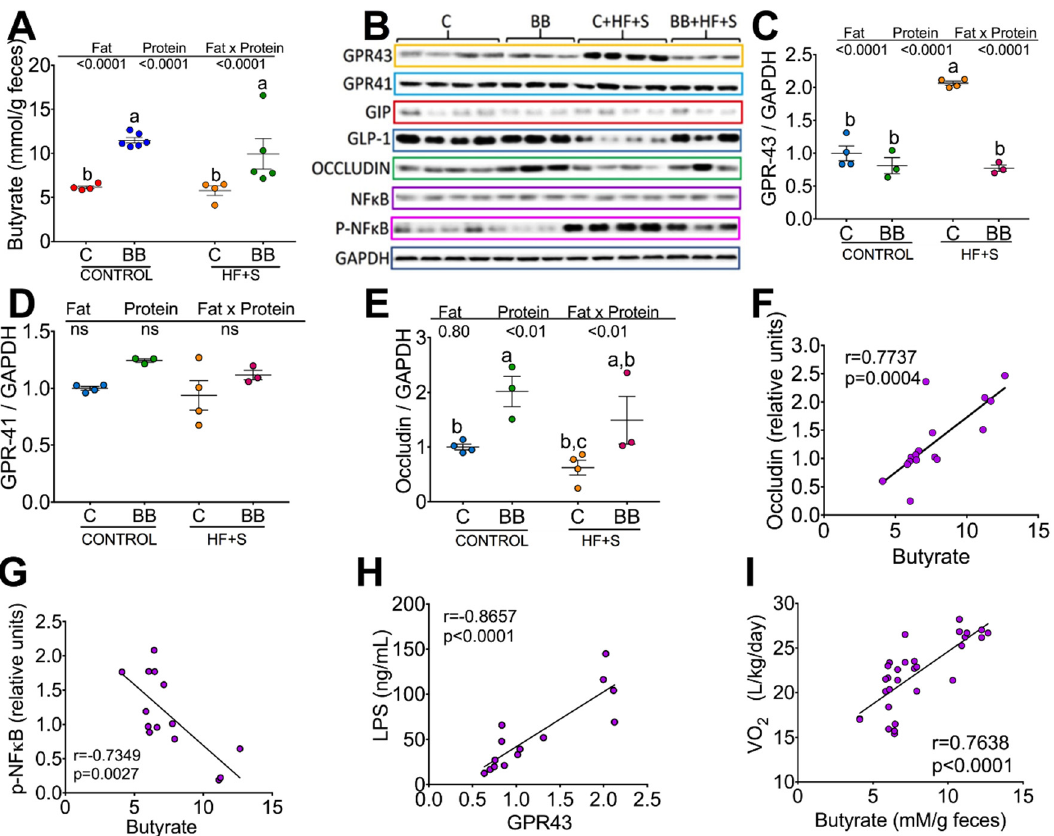
Figure 4. Consumption of black bean increases butyrate and decreases NF- κ B protein abundance in the colon. ( A ) Fecal butyrate concentration, ( B ) Western blot analysis of G protein-coupled receptor (GPR) 41 and 43, occludin, NF- κ B, P-NF- κ B, ( C – E ) and densitometric analysis of GPR41, GPR43 and occludin after 2 months of dietary treatments with casein [C], black bean [BB], Casein + high-fat + S 5% [C + HF + S], BB + HF + S. ( F ) Correlation between occludin and butyrate, ( G ) correlation between NF- κ B and butyrate, ( H ) correlation between LPS and GPR43. ( I ) correlation between VO2 and fecal butyrate concentration.